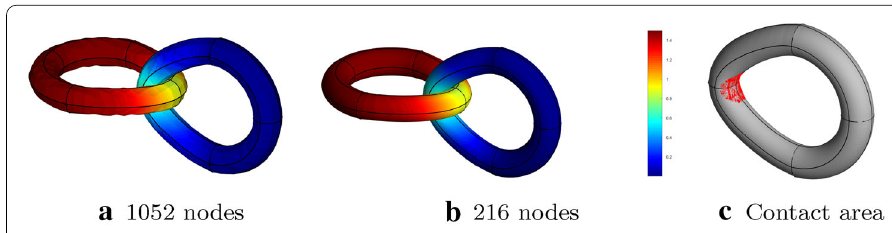
Fig. 15 Example 2. Finite deformations with Neo-Hookean material. Deformed shape using a Linear facets, b NURBS + FE solution. The color map represents values of (cid:8) u h (cid:8) . c Surface integration points with active contact